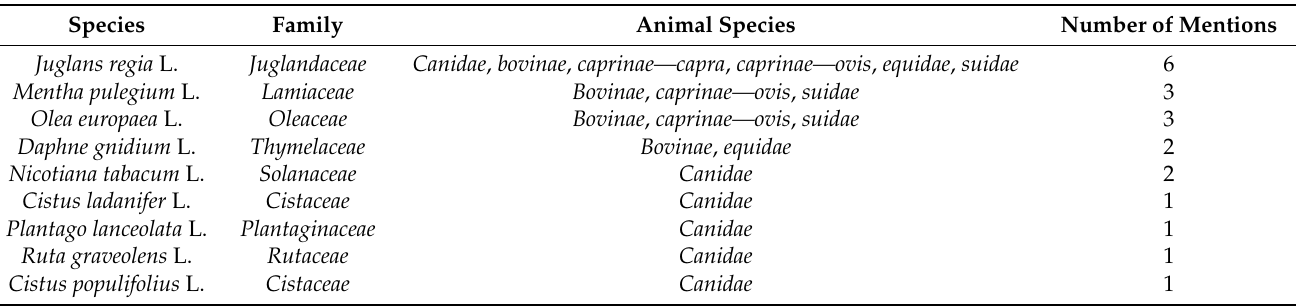
Table 2. Plants mentioned in the ethnobotanical survey with ectoparasiticide potential for dogs and livestock.